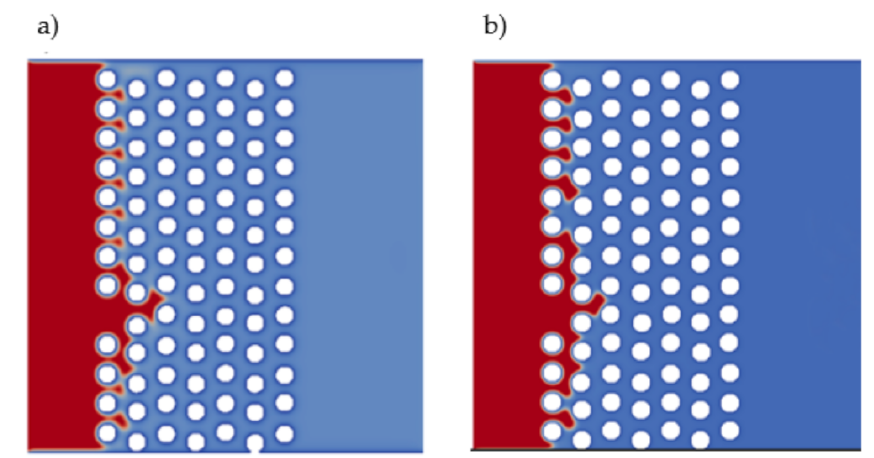
Figure 5. Gaseous phase (red) penetration for circular pores at the 12,500th time-step, C a = 0.038 with different forcing schemes: ( a ) velocity-shift; ( b )